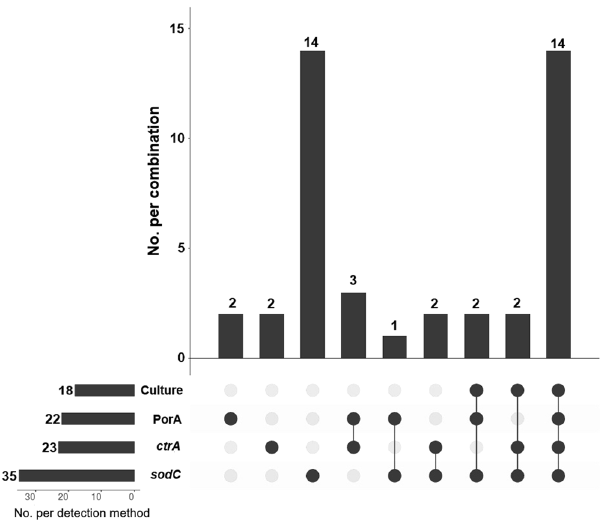
Figure 3. An UpSet plot of the numbers of pharyngeal swabs testing positive for meningococcal carriage by detection method. The bars and numbers to the bottom left represent the numbers of swabs positive for each detection method. The bars and numbers above represent the combinations of positive detection methods for all positive swabs as indicated below (n = 42). Combinations not represented by at least one swab were